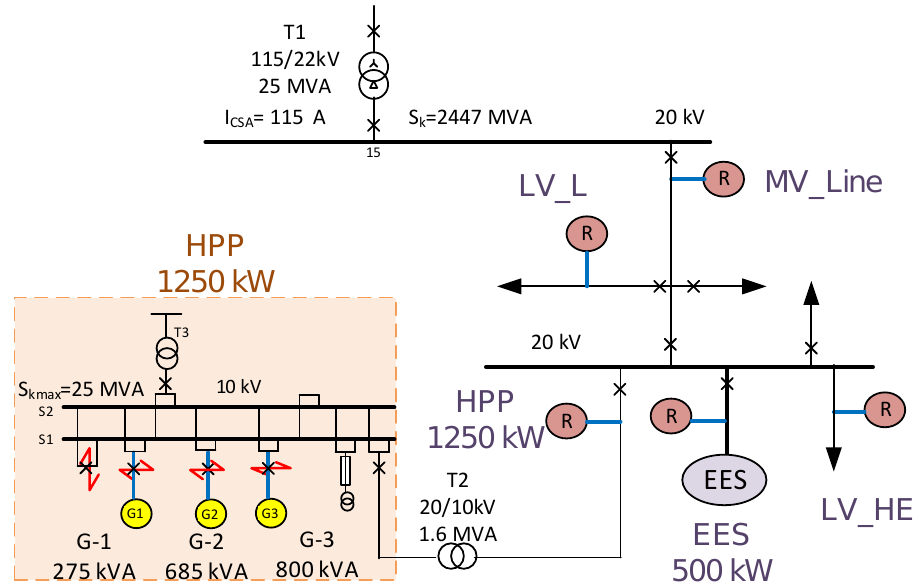
Figure 1. Investigated part of VPP with the placement of PQ recorders.